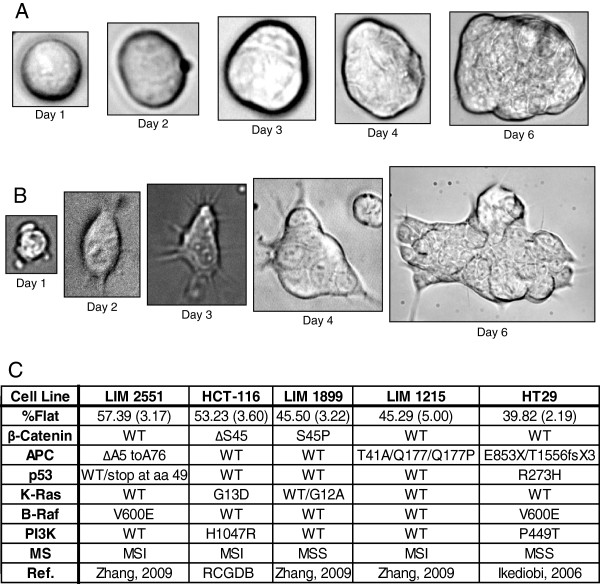
Established colon cancer cell lines grow as disc (flat) or round (spheroid) colonies in 3D. A) Phase images of HCT-116 cells grown in 3-D matrigel, with EGF (E), Noggin (N), Wnt3a (W), and R-Spondin1 (R) (RNEW) media. Images were captured on day 1, 2, 3, 4, and 6, and show colonies that grew as round spheres. B) Phase images of HCT-116 cells grown in 3-D matrigel as in (A). Images show colonies that grew as flat discs. C) Summary of colony phenotypes of colon cancer cell lines grown in 3-D matrigel with RNEW media. Top row shows percentage of disc colonies, with SEM in parenthesis, n>3. Subsequent rows depict mutational status of genes known to drive in colon cancer development RCGDB (Roche Cancer Genome Database [16]).